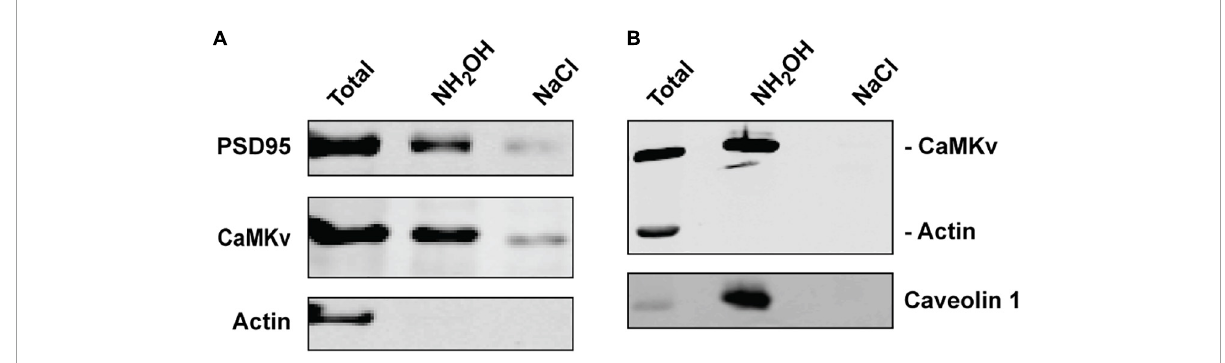
FIGURE2 Palmitoylation of calmodulin kinase-like vesicle-associated (CaMKv). (A) Palmitoylation of endogenous CaMKv in mouse brain homogenate detected by Acyl-RAC (see “Materials and methods” section). PSD95 and actin are shown as positive and negative controls, respectively. Approximately 5% of input was palmitoylated in six separate experiments. (B) Palmitoylation of CaMKv expressed in HeLa cells. Caveolin and actin are positive and negative controls, respectively. Approximately 7% of input was palmitoylated in two separate experiments.